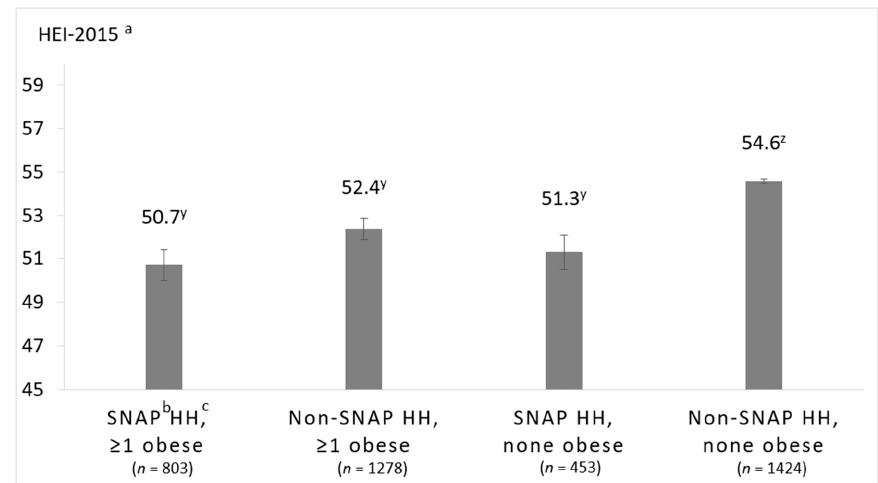
Figure 4. Multivariable-adjusted least square means of total HEI-2015 score of household grocery purchases of households participating in the National Household Food Acquisition and Purchase Survey 2012–2013, ( n = 3958), stratified by weight status (none obese vs. ≥ 1 obese, with obesity defined as body mass index (BMI) ≥ 30 kg/m 2 ) and SNAP-participation. a Healthy Eating Index 2015, b Supplemental Nutrition Assistance Program, c household. Adjusted for age of the primary respondent, family income-to-poverty ratio, any smoker in the household, and education level of the primary respondent. Between-group di ff erences were determined by post hoc tests using Tukey’s method, testing all pairwise comparisons. Scores with di ff erent superscripted letters (e.g., y and z) indicate significant post hoc di ff erences between groups ( p < 0.05). Nutrients 2020 , 12 , x FOR PEER REVIEW